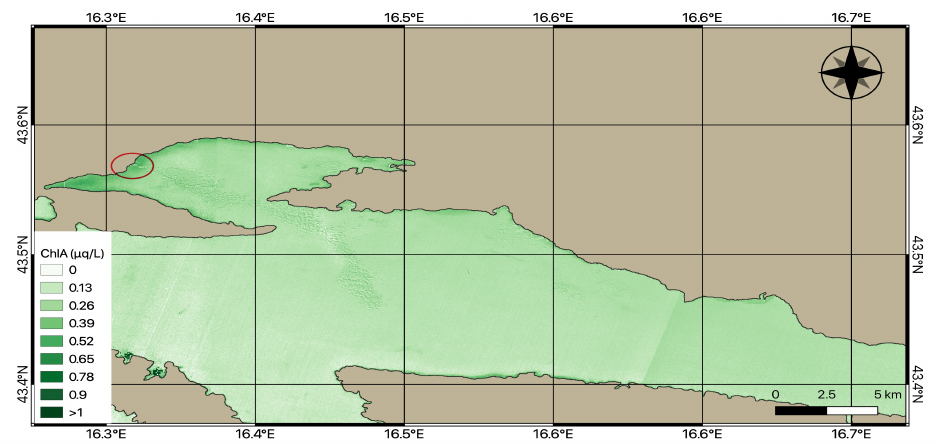
Figure 9. Map of the predicted Chlorophyll-a and its distribution over Kaštela Bay and the Braˇc Channel on 2 April 2021—algae blooms